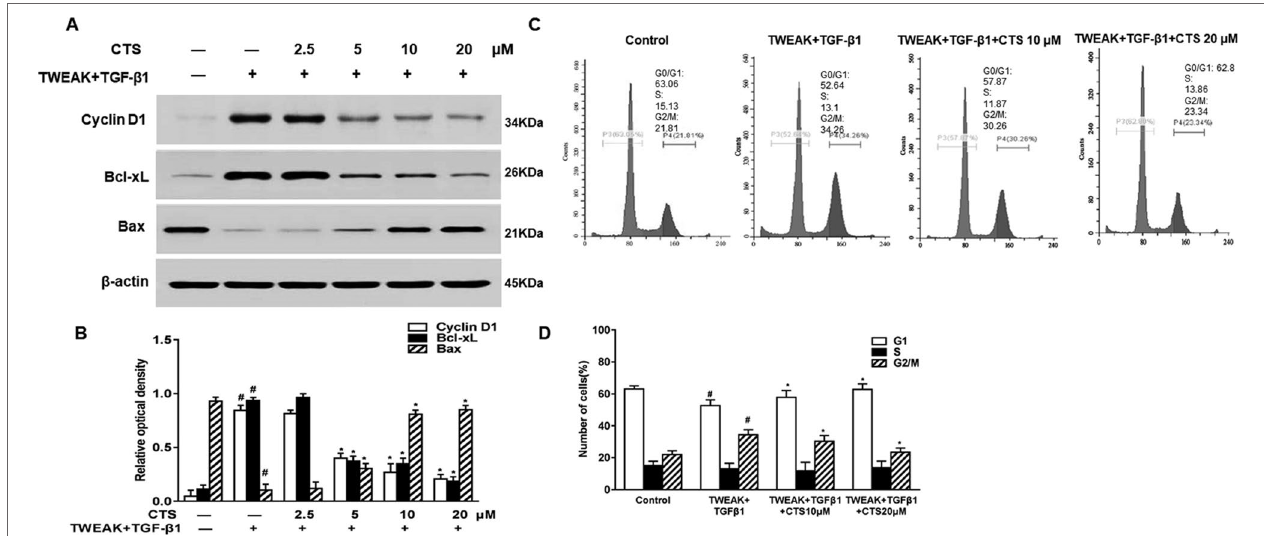
FIGURe 4 | The effect of cryptotanshinone (CTS) on the proliferation of TWEAK + TGF-β1-induced ASMCs is dependent on B-cell lymphoma-extra large (Bcl-xL)/ Bax. TWEAK + TGF-β1-induced ASMCs were treated with the indicated concentrations of CTS for 24 h. (A) The protein expressions of cyclin D1, Bcl-xL, and Bax were analyzed by Western blot. (B) The band intensities of these proteins were quantified in relative to β-actin. (C) Representative flow cytometry images of cell cycle analysis of TWEAK+TGF-β1-induced airway smooth muscle cells (ASMCs) after treated with different doses of CTS for 24 h. (D) The fractions of ASMCs in G0/G1, S, and G2/M were measured. Data were presented as mean ± SEM (n = 3). #P < 0.05 vs. untreated group; *P < 0.05 vs. TWEAK + TGF-β1 group.